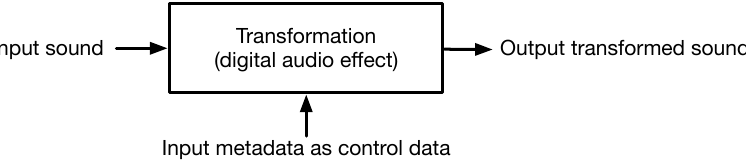
Figure 9. Signal flow of an adaptive audio effect using control parameters obtained from